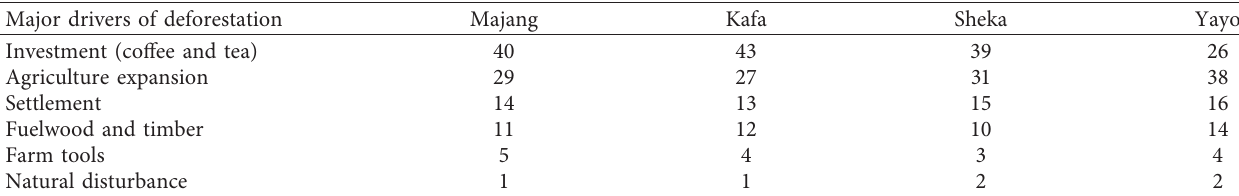
Table 3: Major drivers of deforestation (%) in the biosphere reserves of Southwest Ethiopia.